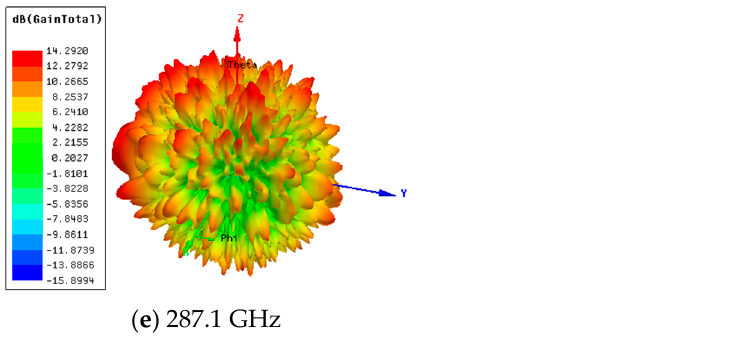
Figure 6. The 3D gain polar plots of the final iterative design of the proposed tapered-fed structure with partial ground plane.